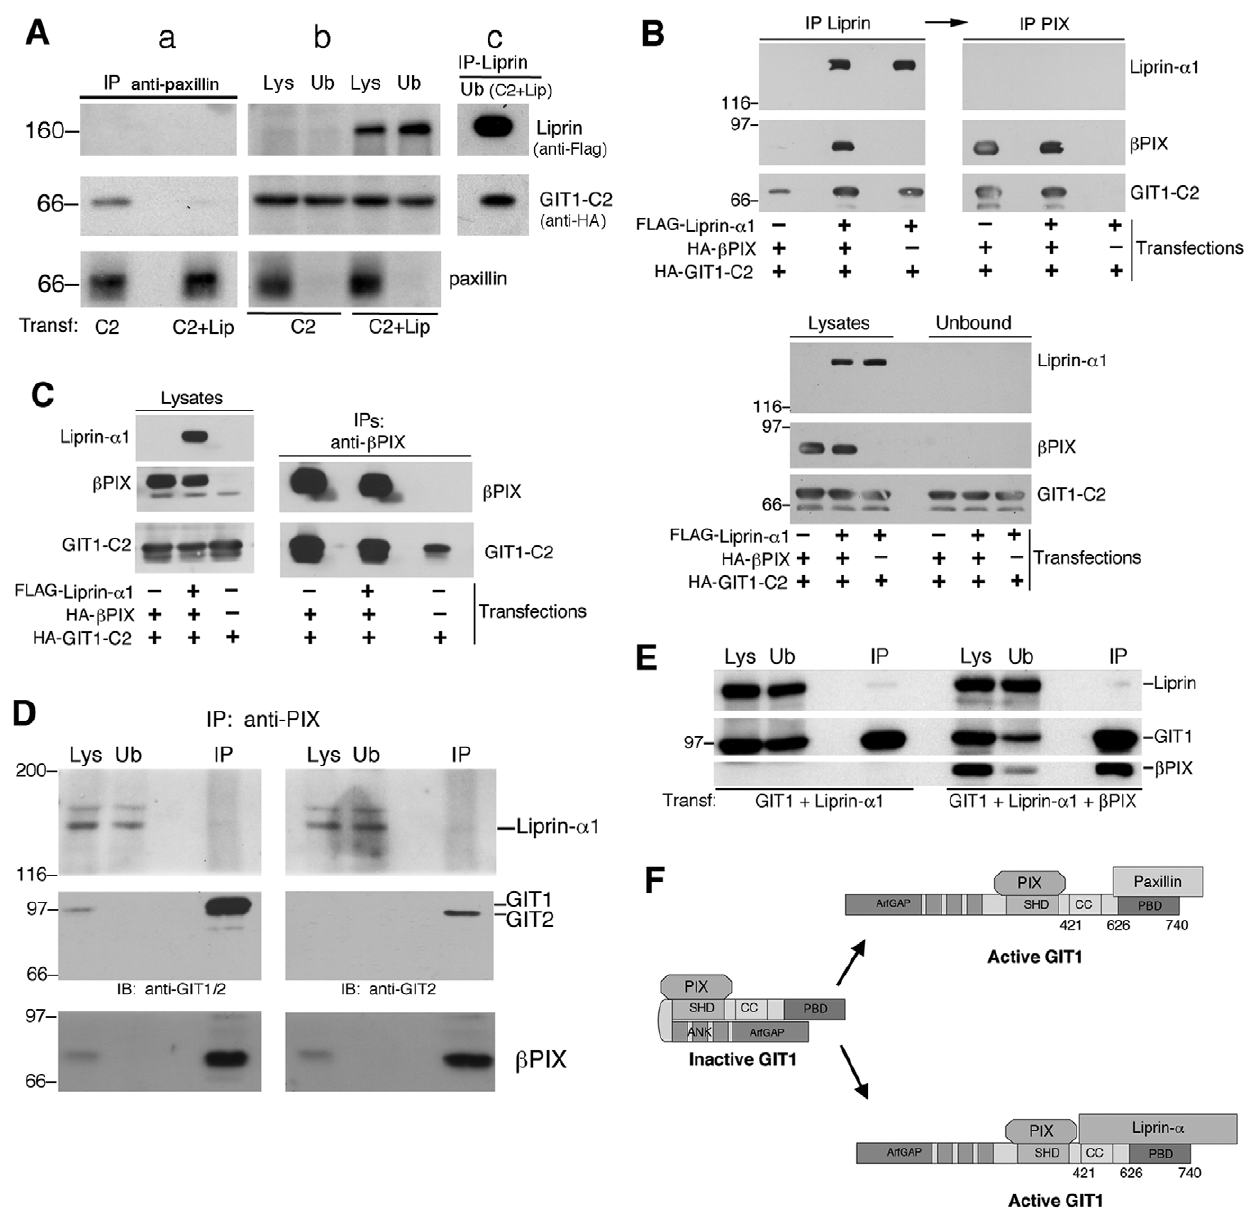
Figure 1. Binding of liprin- a 1 to GIT1-C2 prevents binding of paxillin to GIT1-C2. (A) Lysates were prepared from COS7 cells transfected with either HA-GIT1-C2 (C2) or co-transfected with HA-GIT1-C2 and FLAG-liprin- a 1 (C2 + Lip). Aliquots of the lysates were used for immunoprecipitation with anti-paxillin antibodies (IP anti-paxillin, 400 m g of protein per IP). Filters with immunoprecipitates (a), and with 100 m g of both lysates (Lys) and unbound fractions after IP (Ub) (b) were cut and immunoblotted with anti-Flag to detect Flag-liprin- a 1 (upper filters, only one of the duplicated immunoprecipitations is shown); since GIT1-C2 and paxillin migrate at similar positions on gels, the lower parts of the filters from the duplicated immunoprecipitations were used as follows: one set of filters (a + b) was incubated with anti-HA to detect HA-GIT1-C2 (middle blots), and one set was incubated with anti-paxillin to detect endogenous paxillin (lower blots). Paxillin was absent from the unbound fractions after immunoprecipitation (Ub). (c) The unbound fraction (300 m g) after immunoprecipitation with anti-paxillin from the lysate of cells co-transfected with HA-GIT1-C2 and FLAG-liprin- a 1 [Ub(C2 + Lip)], was re-immunoprecipitated with anti-liprin antibody, to reveal the presence of the liprin- a 1/GIT1-C2 complex in the lysate. (B) Binding of liprin- a 1 to GIT1-C2 does not prevent binding of b PIX to GIT1-C2. Identification of a ternary complex among liprin- a 1, b PIX and GIT1-C2. COS7 cells co-transfected to express the indicated combinations of HA-GIT1-C2, HA- b PIX, and FLAG-liprin- a 1 were immunoprecipitated with anti-FLAG antibodies (top blots on the left). Aliquots of the unbound fraction after the first round of immunoprecipitations were re-immunoprecipitated with anti- b PIX antibodies (top blots on the right). Filters including immunoprecipitations (IP), lysates (Lys), and unbound fractions after the second round of immunoprecipitations (Ub) were cut and blotted as indicated (lower blots). (C) Liprin- a 1 does not interfere with the interaction of b PIX with GIT-C2. COS7 cells co-transfected to express the indicated combinations of HA-GIT1-C2, HA- b PIX, and FLAG-liprin- a 1 were immunoprecipitated with anti- b PIX antibodies. Filters including aliquots of lysates and the immunoprecipitations (IP) were cut and blotted as indicated. (D) A COS7 cell lysate (1 mg protein) was immunoprecipitated with anti- b PIX antibodies. Immunoprecipitate (IP) and equal amounts (100 m g) of lysate (Lys) and unbound fraction (Ub) were blotted with anti-GIT (mAb PKL, recognizing both GIT1 and GIT2 proteins, on the left; or anti- GIT2-specific pAb, on the right), b PIX, or anti-liprin- a 1 antibodies. Blot with anti-GIT antibody was performed after stripping the filter incubated for b PIX. (E) binding of b PIX to full length GIT1 does not enhance the binding of liprin- a 1 to GIT1. COS7 cells were co-transfected with FLAG-liprin- a 1 and